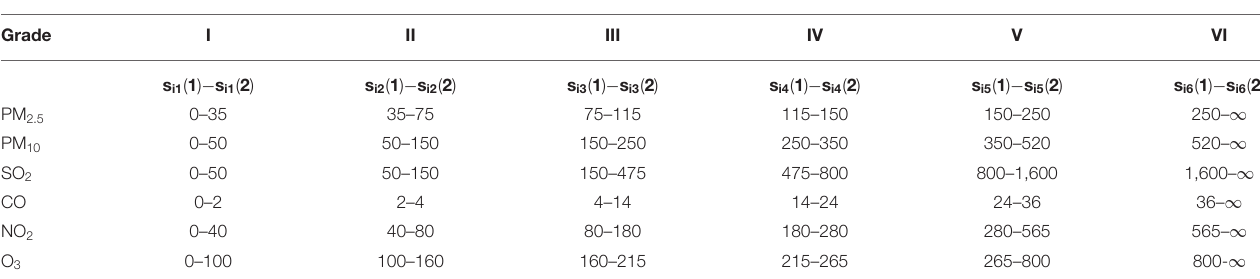
TABLE 3 | Multiple slope member function